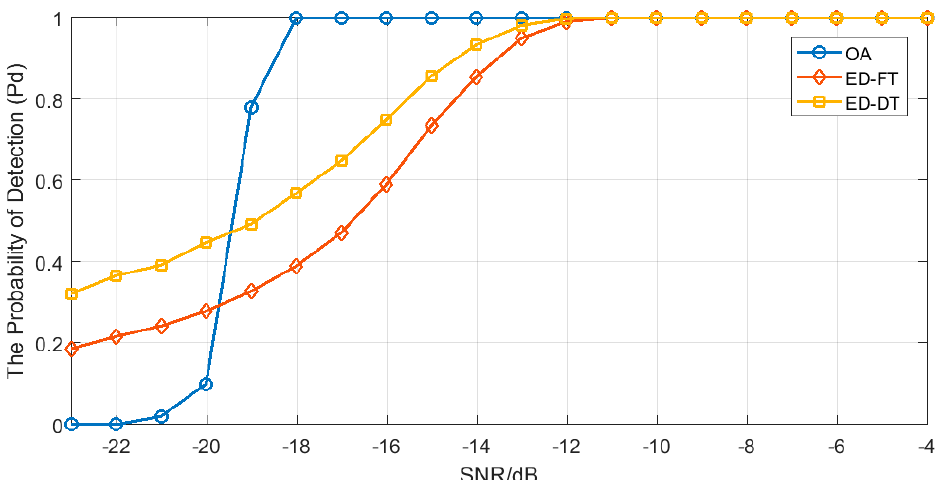
Figure 12. Comparison of the detection probability under different SNR between the multi-resolution singular spectrum entropy (MRSSE) algorithm and traditional spectrum sensing algorithms (OA: MRSSE algorithm; ED-FT: the energy detection algorithm with fixed threshold; ED-DT: the energy detection algorithm with adaptive threshold).